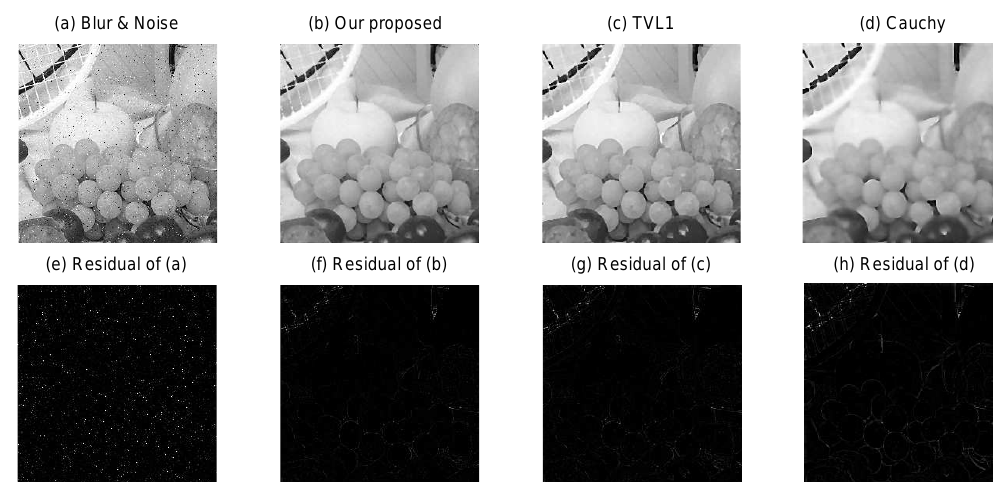
Figure 6. Recovered Boat images from different methods.